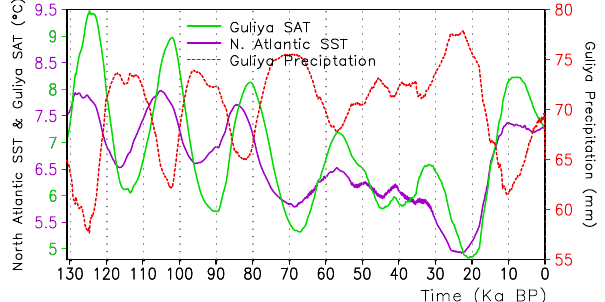
Fig. 13 . The simulated August–September Guliya SAT (green; left ordinate), Fig. 13. The simulated August–September Guliya SAT (green; left ordinate), North Atlantic SST (30 ◦ W–30 ◦ E, 60 ◦ –75 ◦ N) (pur- North Atlantic SST (30°W–30°E, 60°–75°N) (purple; left ordinate) and ple; left ordinate) and precipitation (red; right precipitation (red; right ordinate).